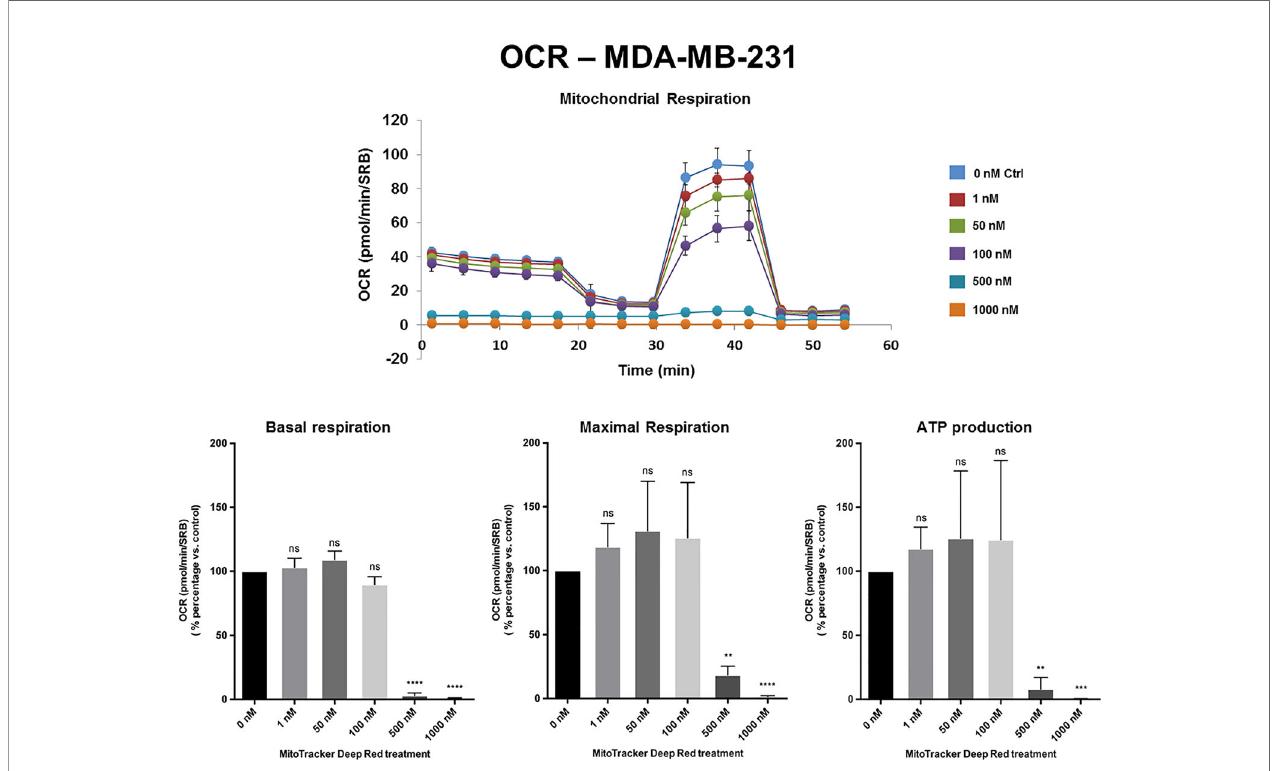
FIGURE 3 | MTDR potently inhibits the mitochondrial OCR in MDA-MB-231 cells. A representative Seahorse tracing is shown, with bar graphs highlighting the quantitative, dose-dependent effects of MTDR on basal respiration, maximal respiration and ATP production. Note that MTDR treatment exhibits near complete inhibition of OCR in MDA-MB-231 cells at 500 nM. The statistical test used was a one-tail unpaired